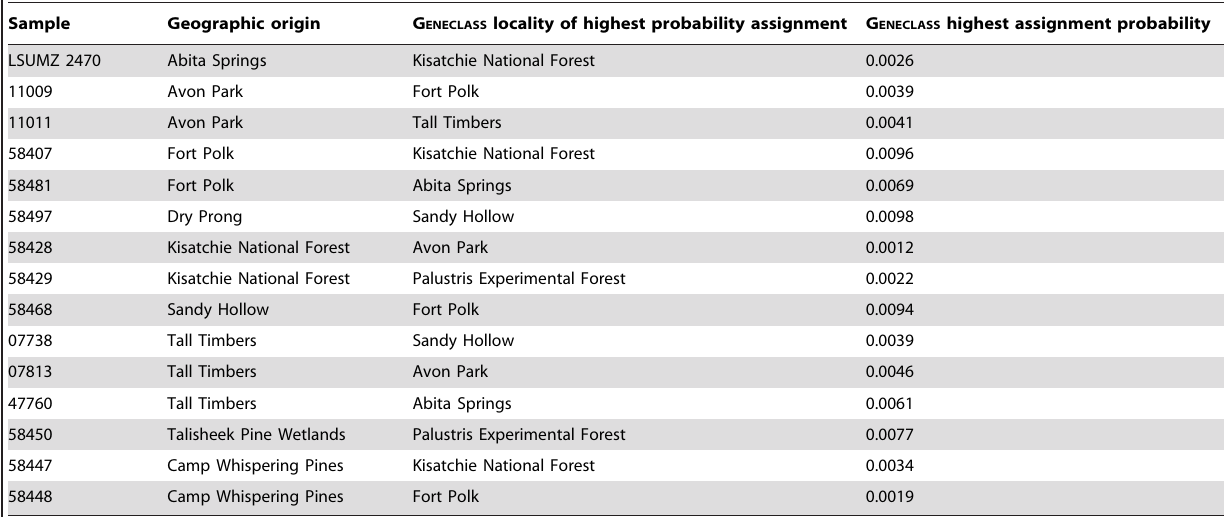
Table 7. Results of migrant detection analysis in GENECLASS showing individuals with significant assignment probabilities (p , 0.01) for population origins other than the study site in which they were